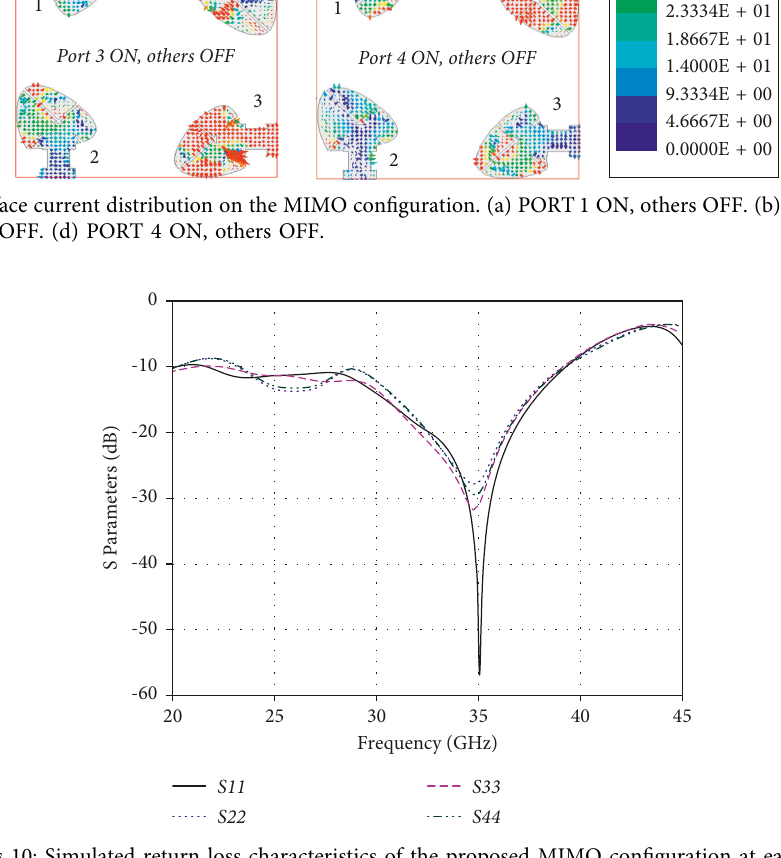
Figure 10: Simulated return loss characteristics of the proposed MIMO configuration at each